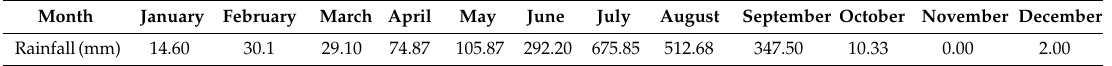
Table 1. Average monthly rainfall during July 2017–August